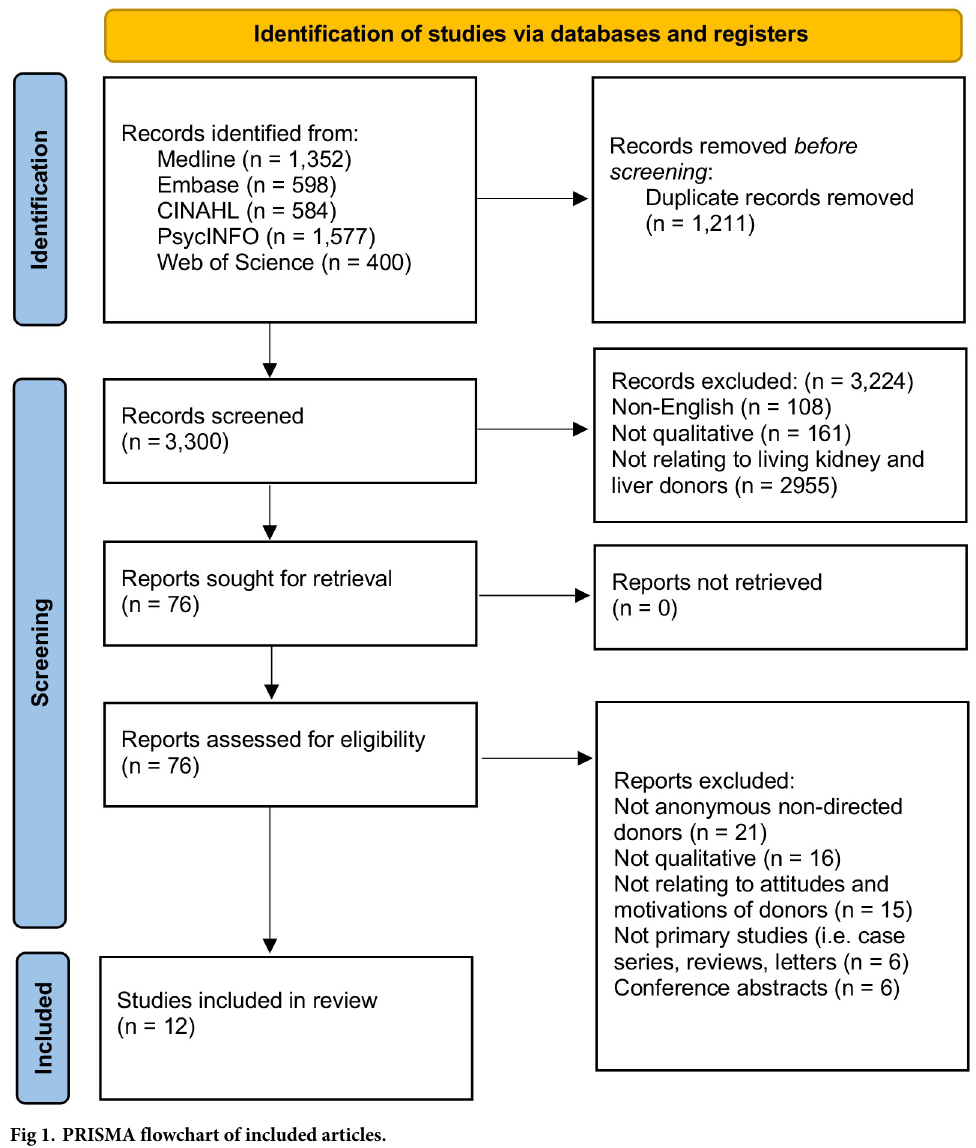
Fig 1. PRISMA flowchart of included